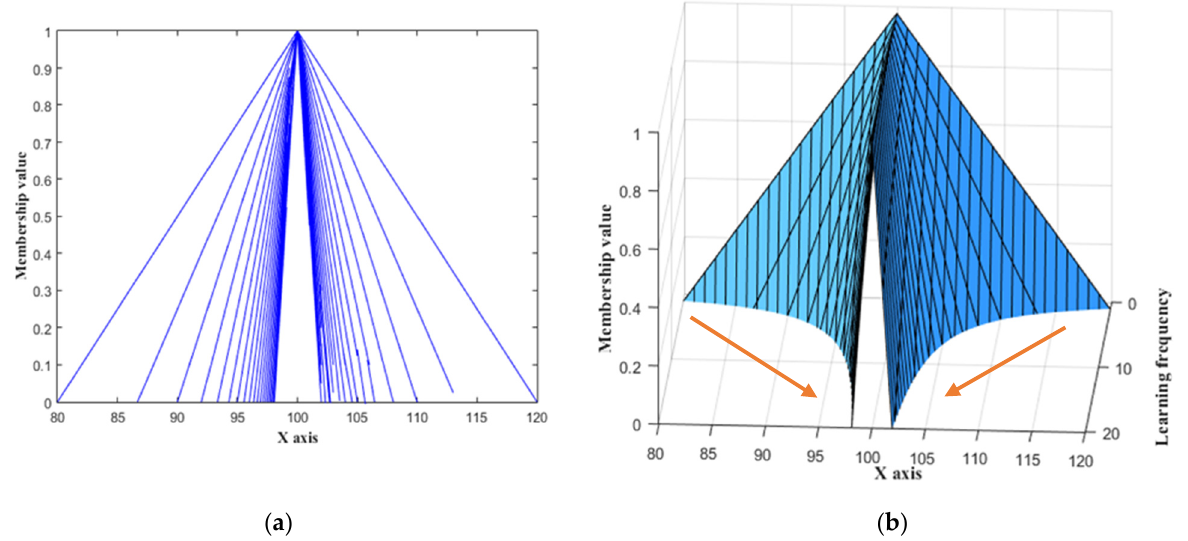
Figure 1. ( a ). Graph of membership function of triangular dense fuzzy number against learning frequency; ( b ) graph of membership function of triangular dense fuzzy number against learning frequency.